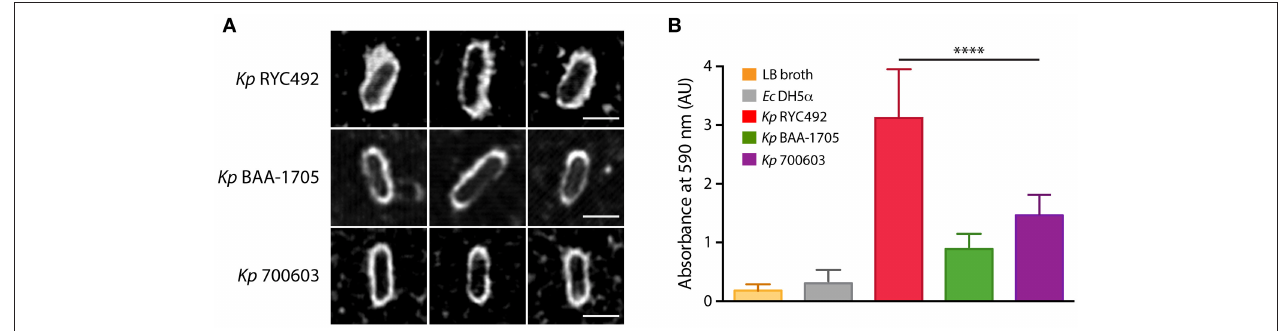
FIGURE 6 | Klebsiella pneumoniae RYC492 virulence correlates with a more prominent and irregular capsule and with increased biofilm formation ability. (A) K. pneumoniae cells were subjected to classical capsule staining with India ink, and observed and photographed using confocal microscopy. Pictures of 3 representative cells of each bacterial strain are presented. The capsule corresponds to the white area between the bacillary cell and the black background. Scale bar, 2 µ m. (B) Biofilm formation assessment of K. pneumoniae strains or E. coli DH5 α upon growth in a 96-well plate during 18h. Bacterial cells adhered to the wells were stained with crystal violet, where biofilm formation is proportional to the absorbance of the bound stain (measured at 590nm). The values shown correspond to the mean of three independent experiments and the error bars represent the standard deviation. RYC492 strain showed a significantly higher ability to form biofilms than Kp 700603 (one-way ANOVA, **** p < 0.0001), and then the rest of the bacterial strains